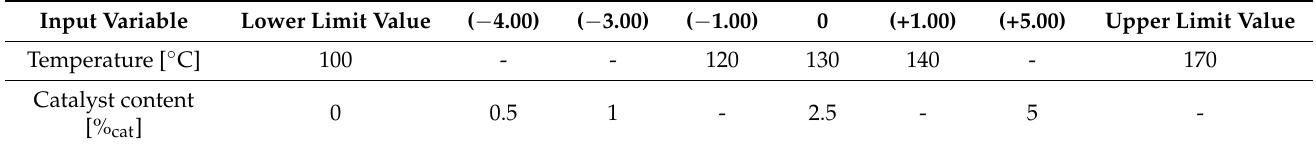
Table 4. Values of coded input variables.